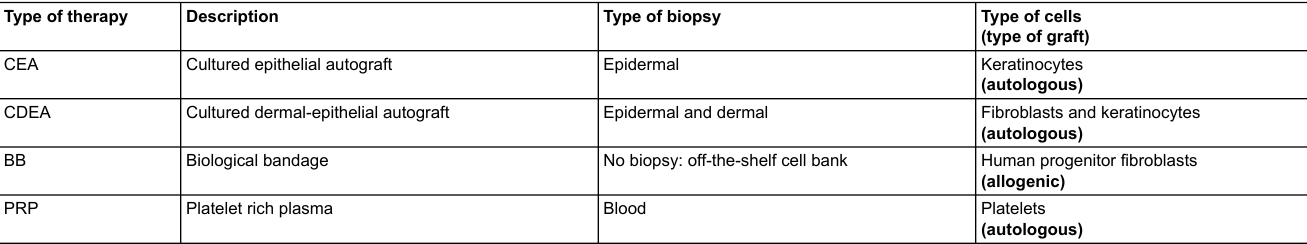
Table 1: Summary of different cell therapies used at the CHUV Burn Centre. Type of therapy